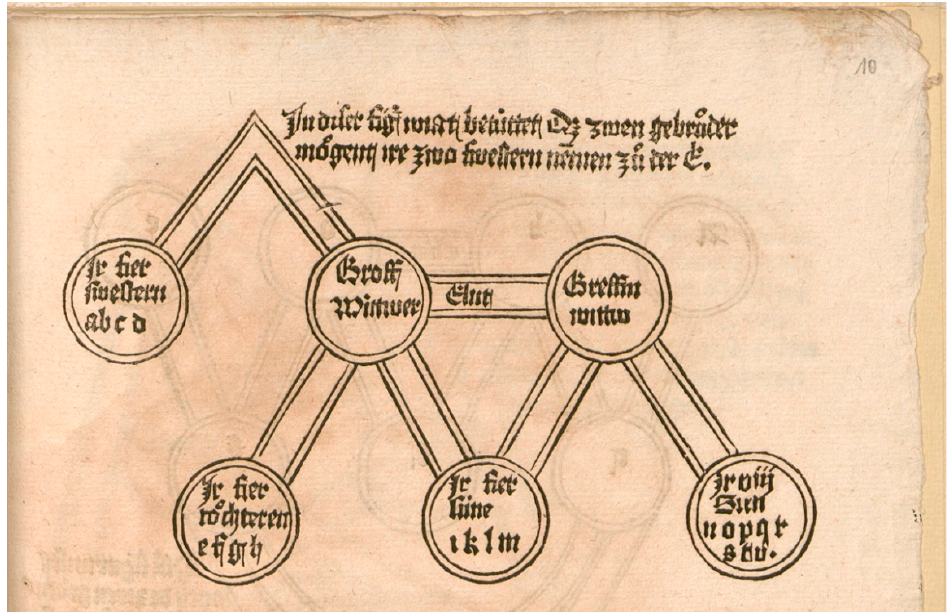
Figure 3. A visual solution of the riddle of the count and the twelve knights as it appears in a German-language printed edition of Johannes Andreae, Super arboribus consanguinitatis et affinitatis , Strasbourg: Heinrich Knoblochtzer, c. 1482/3, 10 r . Attribution: Bayerische Staatsbibliothek, Munich, Germany. CC BY-NC-SA 4.0.